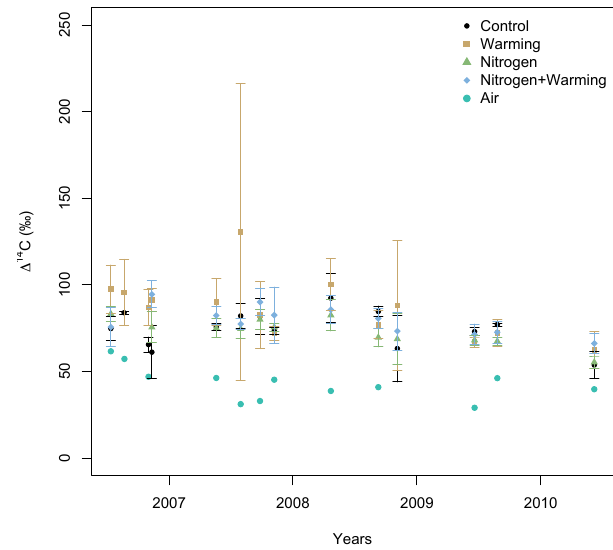
Fig. 3. Assessment of model performance comparing predictions with observations of 1 14 C of soil C fractions. Points are measure- ments; lines are model results from Gaudinski et al. (2000). The Oe/a fraction combines the Oe/a L and Oe/a H fractions of the orig- inal model. Similarly, A-LF ( < 80µm) and A-LF ( > 80µm) were combined in a single fraction.